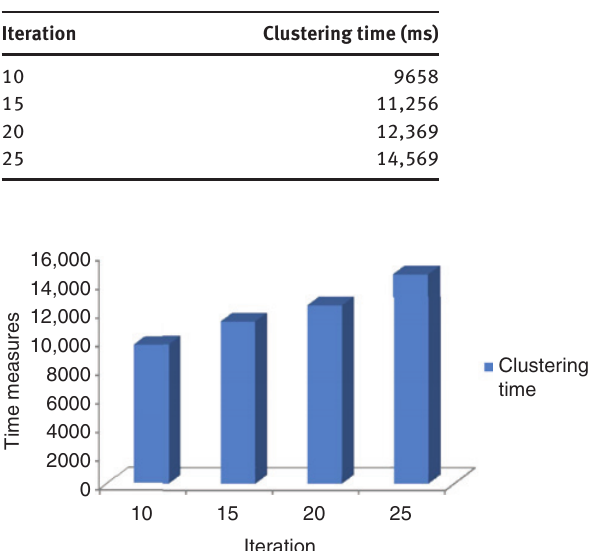
Table 2: Clustering Time Measures for Our Proposed Research.